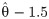
Simulation results for seven Bayesian procedures (uniform prior for spreads).Each line corresponds to 1000 simulations for different number of trials for one simulated subject. The parameters of the modelled subject were σS = 1 (i.e.β = 7.327); αS = 1.488 (2AFC) or αS = 1.387 (4AFC); π = 0.75; γS = 0.5 (2AFC) or γS = 0.25 (4AFC); λS = 0.02 (2AFC) or λS = 0.03 (4AFC); δS = 0.012 (2AFC) or δS = 0.018 (4AFC), and threshold of θS = 1.5 log10 arcsec. Left panels show the mean of the threshold bias (θ^−1.5), and right panels show the standard deviation of the distribution of the threshold bias. For all procedures, for the prior probability distribution of slopes, we have assumed a uniform distribution. Note that the y-values for Threshold bias are different for 2AFC and 4AFC tasks.